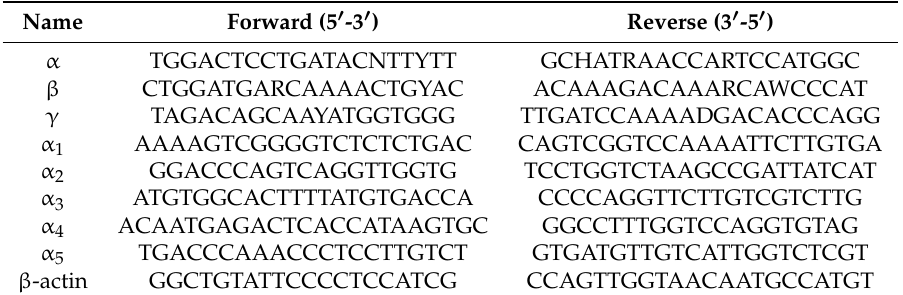
Table 2. Primers used in quantitative real-time polymerase chain reaction (RT-PCR)